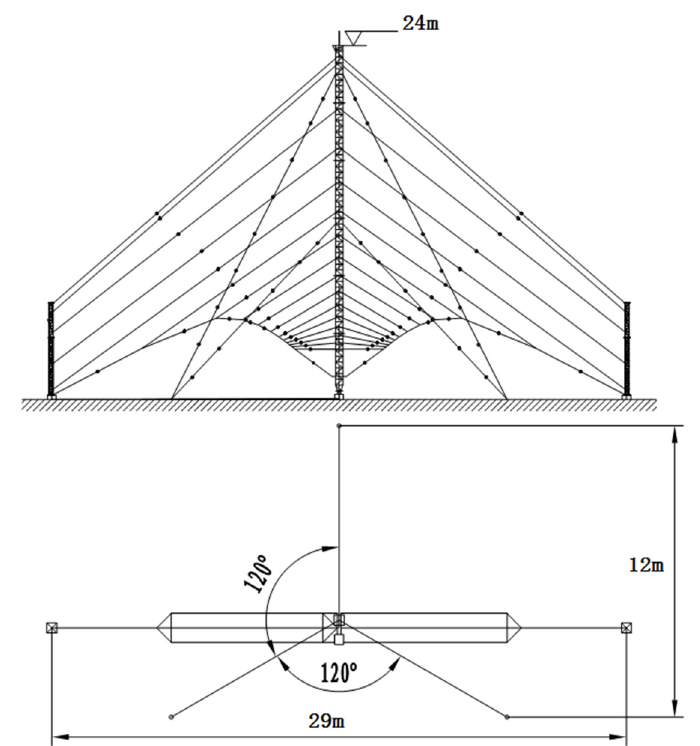
Figure 4. Shape of the miniaturized antenna.